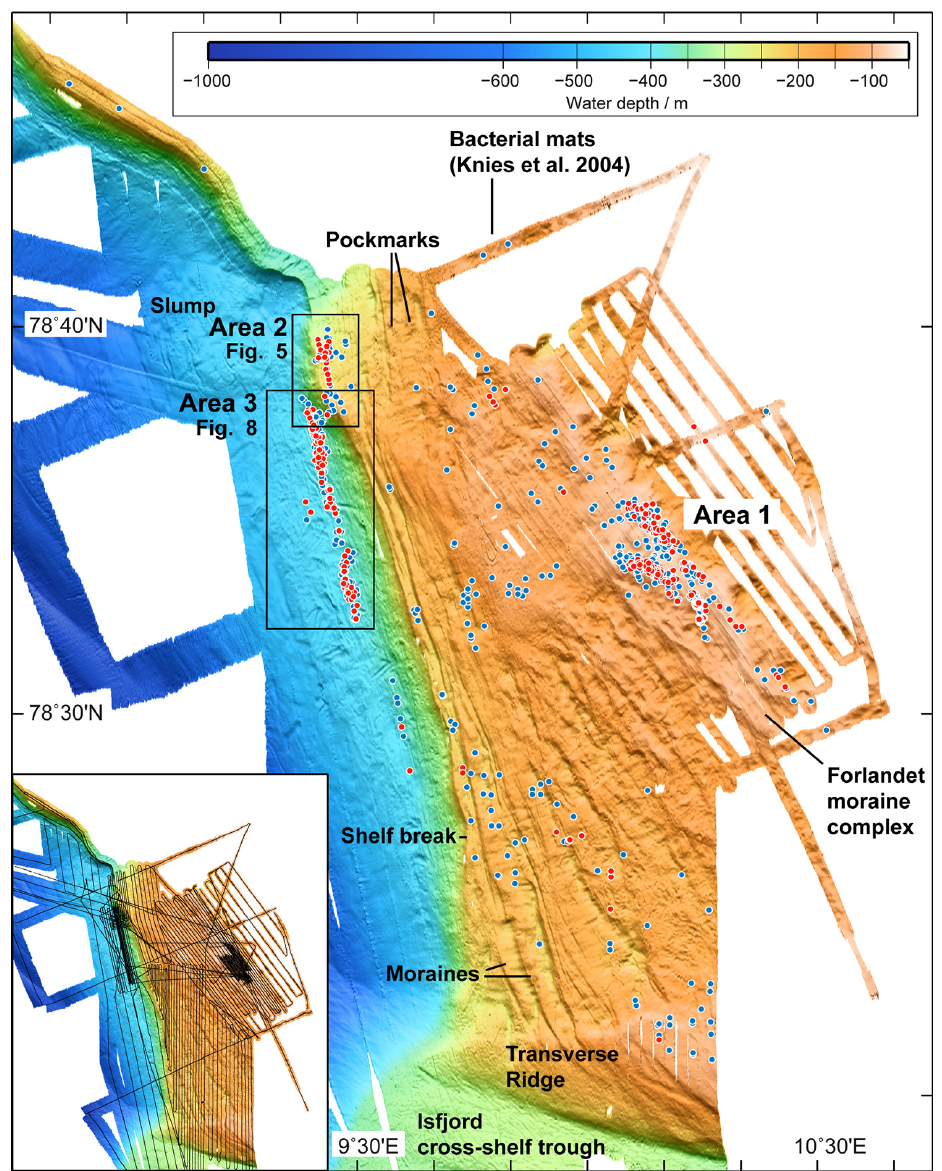
Figure 2. Main figure: location of flares (hydroacoustic indications of gas bubble emissions) during summer 2012 as picked from EK 60 echosounder records plotted on top of multibeam bathymetry. Strong flares (red dots) mainly occur in Areas 1, 2, and 3. Weak flares (blue dots) occur widespread at the shelf. Inset: map of the region showing the ship track and